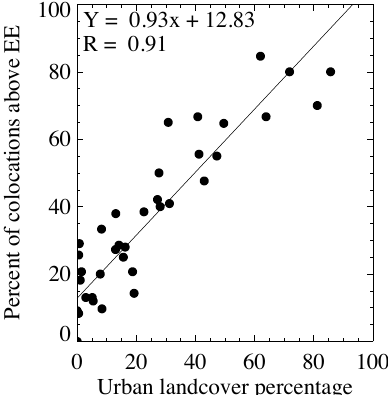
Fig. 9. Percent of 3km spatially averaged MODIS/SP 0.55µm AOD collocations above expected error ( + 0.05+0.15AOD) at each SP station, plotted against the percentage of pixels within the 15km by 15km collocation box identified as urban by the MODIS land cover